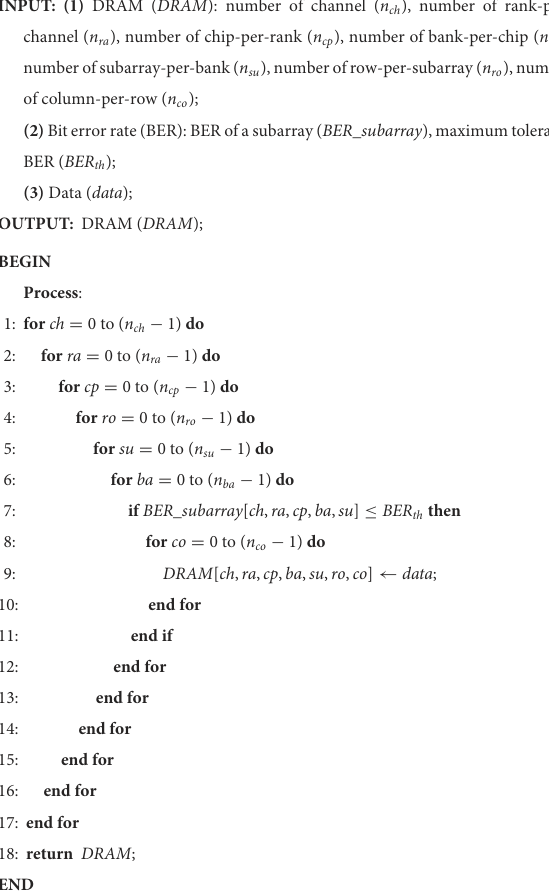
Algorithm 1 The proposed DRAM mapping